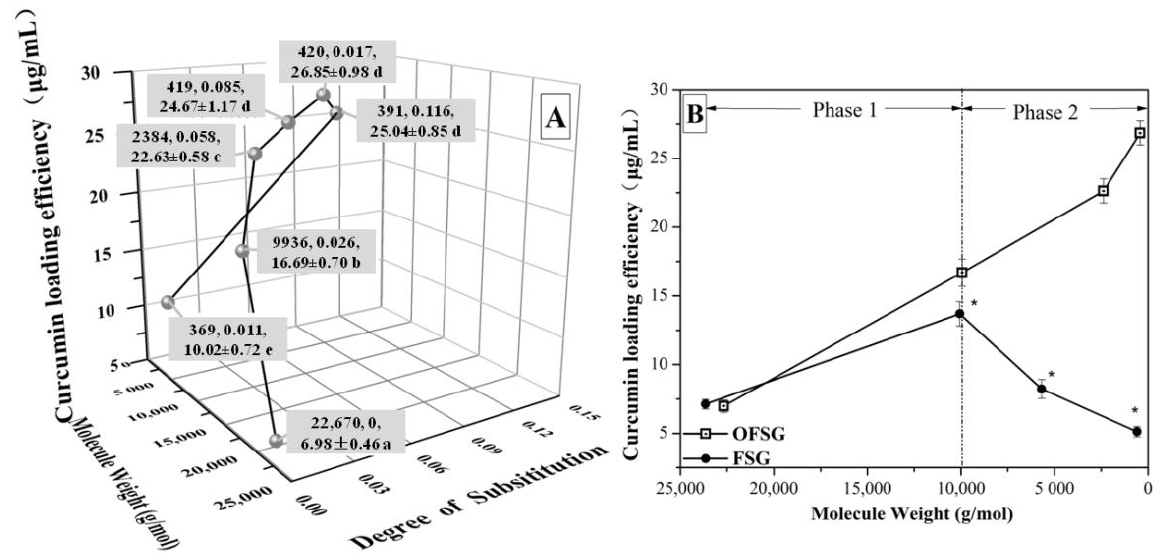
Figure 1. Curcumin loading efficiency (CLE, μg/mL) of fish scale gelatin (FSG) and octenylsuccinate fish scale gelatin (OFSG) with different molecular weights and degrees of substitution ( A , B ). CLE ( B , μg/mL ) bearing asterisks are significantly different ( p < 0.05) between the OFSG and FSG with similar molecular weights.